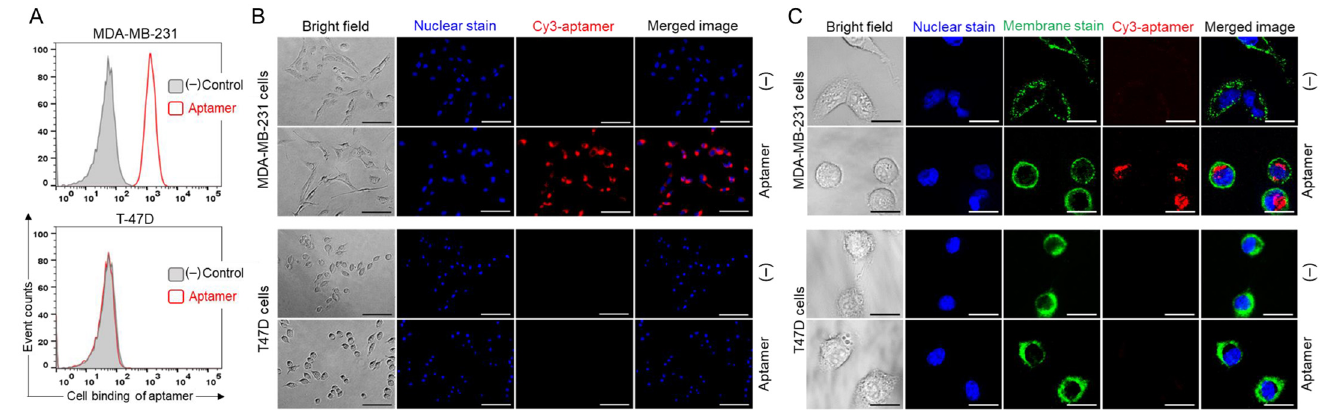
Figure 4. Specific cell binding of PDGC21-T aptamers. ( A ) Flow cytometry analysis of cell binding by Cy3-labeled aptamer probes to MDA-MB-231 (TNBC) and T47D (non-TNBC) cells. ( B ) Fluorescent microscopy of cell binding by Cy3-labeled aptamer probes. For visualization, cell nuclei were stained with Hoechst dye. Scale bar = 100 µm. ( C ) Confocal microscopy revealed aptamer internalization into MDA-MB-231 (TNBC) cells but not T47D (non-TNBC) cells. For visualization of individual cells, nuclei and membranes were stained with Hoechst dye and DiO Cell-Labeling solution, respectively. Scale bar = 25 µm.